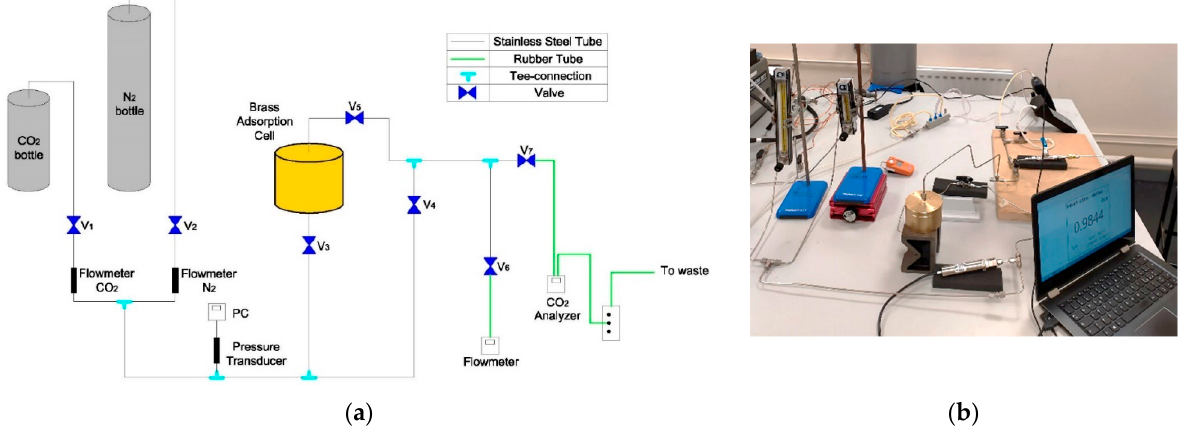
Figure 4. The set-up consisted of the following elements: CO 2 (UN1013, Linde ® , Aberdeen, UK) and N 2 (UN1066-OFN of Linde ® ) pressure bottles; CO 2 and N 2 manual flowmeters (Omega ® ); pressure transducer (Omega ® ) connected to one computer; brass adsorption cell; digital flowmeter (Agilent Technologies ® , Cheadle, UK) and CO 2 analyzer (G110 Geotech ® , Aberdeen, UK).